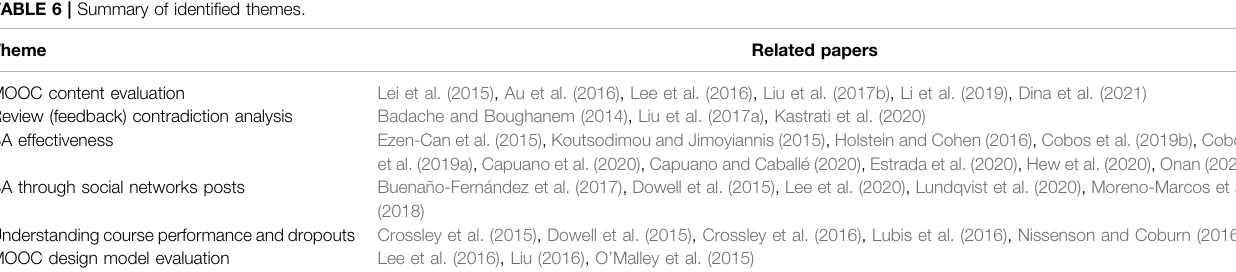
TABLE 6 | Summary of identi fi ed